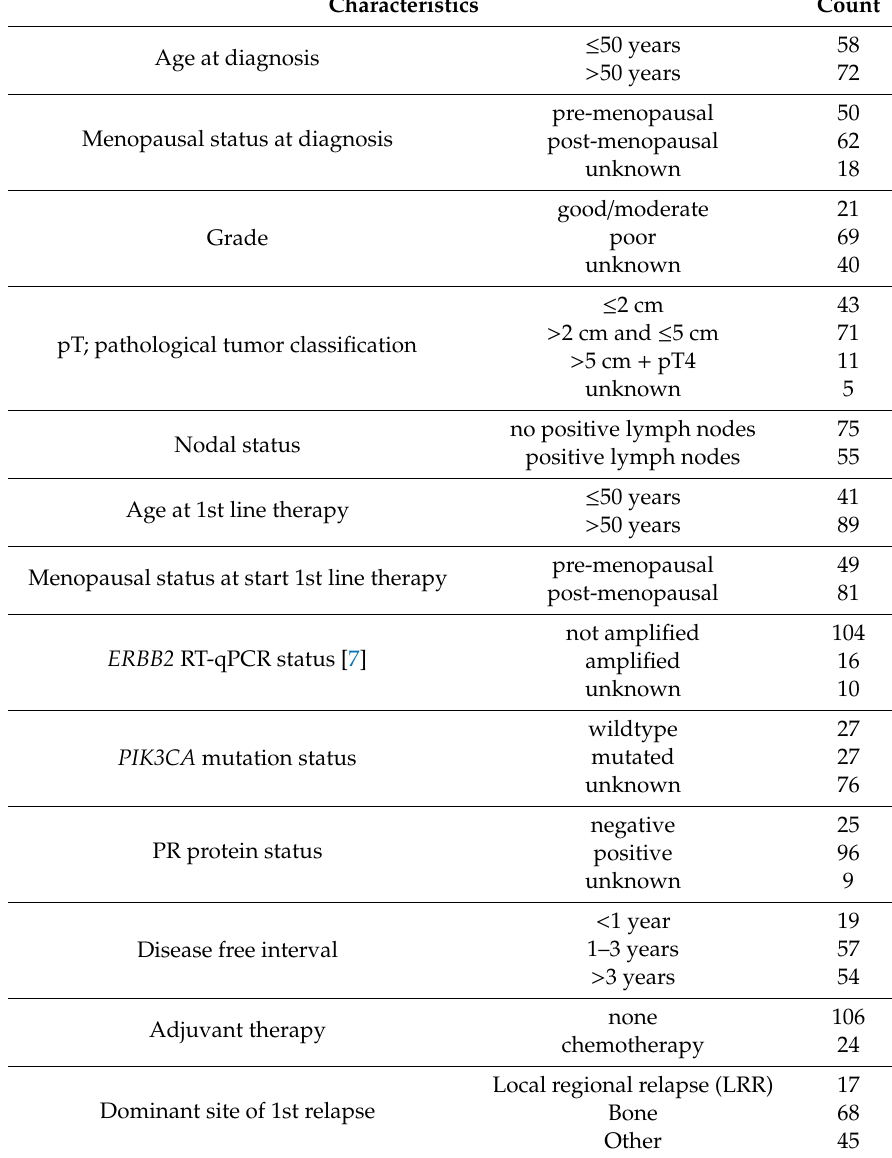
Table 1. Patient